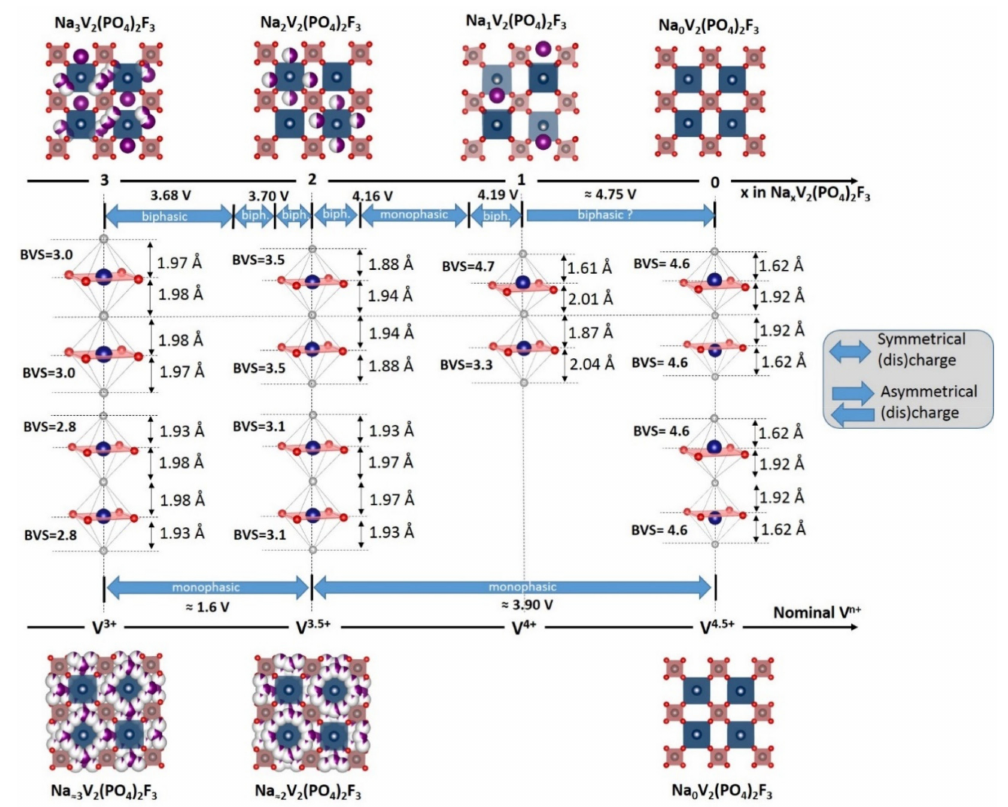
Figure 9. Evolution of vanadium environments and Na/vacancies ordering upon cycling of Na 3 V 2 (PO 4 ) 2 F 3